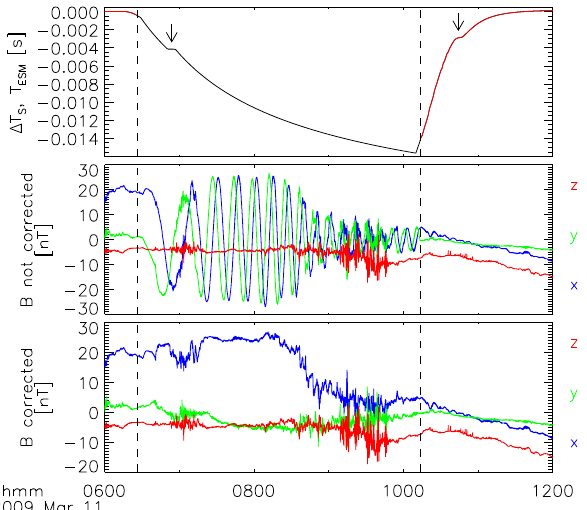
Fig. 5. ES model application to a long eclipse for THEMIS B on 11 March 2009. Top panel: spin period differences to T S ref , mid panel: magnetic field despun with uncorrected spin times, bottom panel: magnetic field despun with corrected spin-times using the ESM. The eclipse time interval is delimited by the dashed lines.